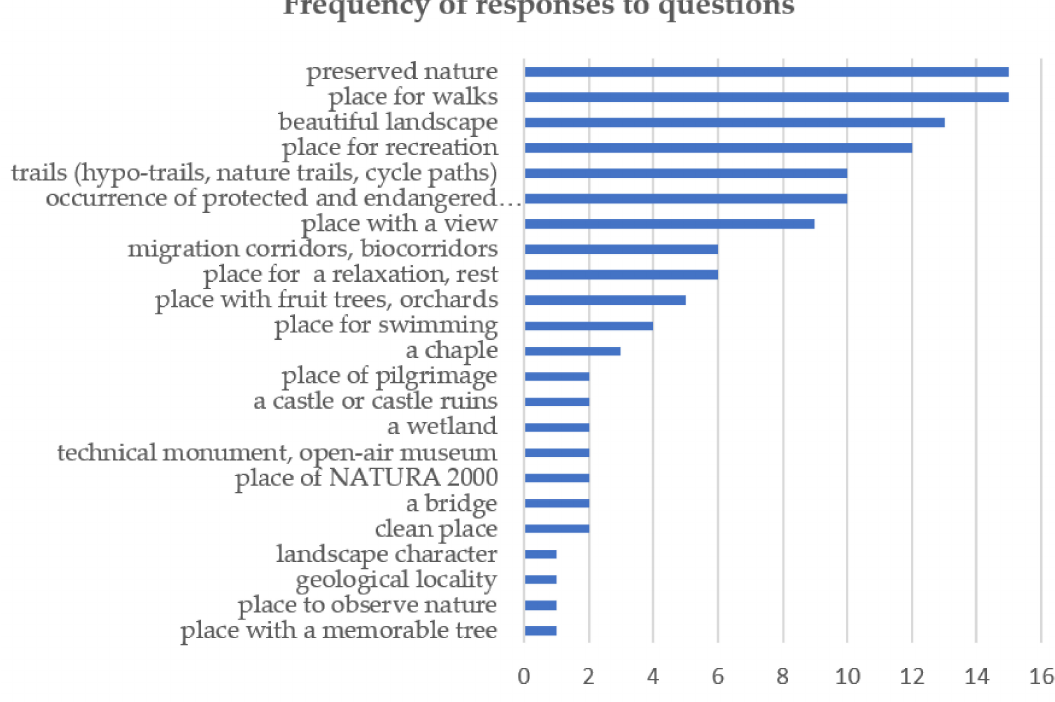
Figure 4. Most preferred valuable areas in the open country listed by all respondents.